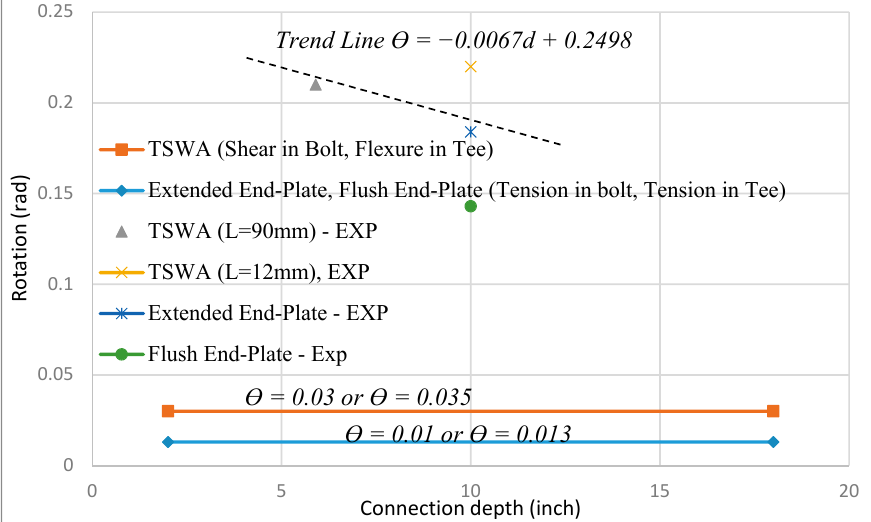
Figure 15. Maximum rotation capacities versus connection depth for flexible connections. Overall, Figures 13 to 15 indicate that the average plastic rotation angle varies from 0.1 to 0.2 rad, which significantly surpasses the UFC recommended acceptance criterion. This indicates that all three beam-to-column connection categories can address adequate plastic rotation during sudden column removal. In addition, the results reveal that the suggested ductility acceptance criteria are on the conservative side for all three beam-to-column connection categories. The current in-practice acceptance criteria employed in progressive collapse analysis are based on cyclic simulations proposed by the American Society of Civil Engineers (ASCE/SEI) 41 13 [46] that do not consider large axial demands imposed over sudden column removal. Actually, the results show that the connection depth alone is not a reliable indicator to predict the rotational capacity of a connection, where different connection types with the same R i result in totally different maximum rotation capacity. Moreover, the results show that although the stiffness of fully rigid connections is higher than flexible connections, both categories result in almost the same rotation capacity, by around 0.15 rad.